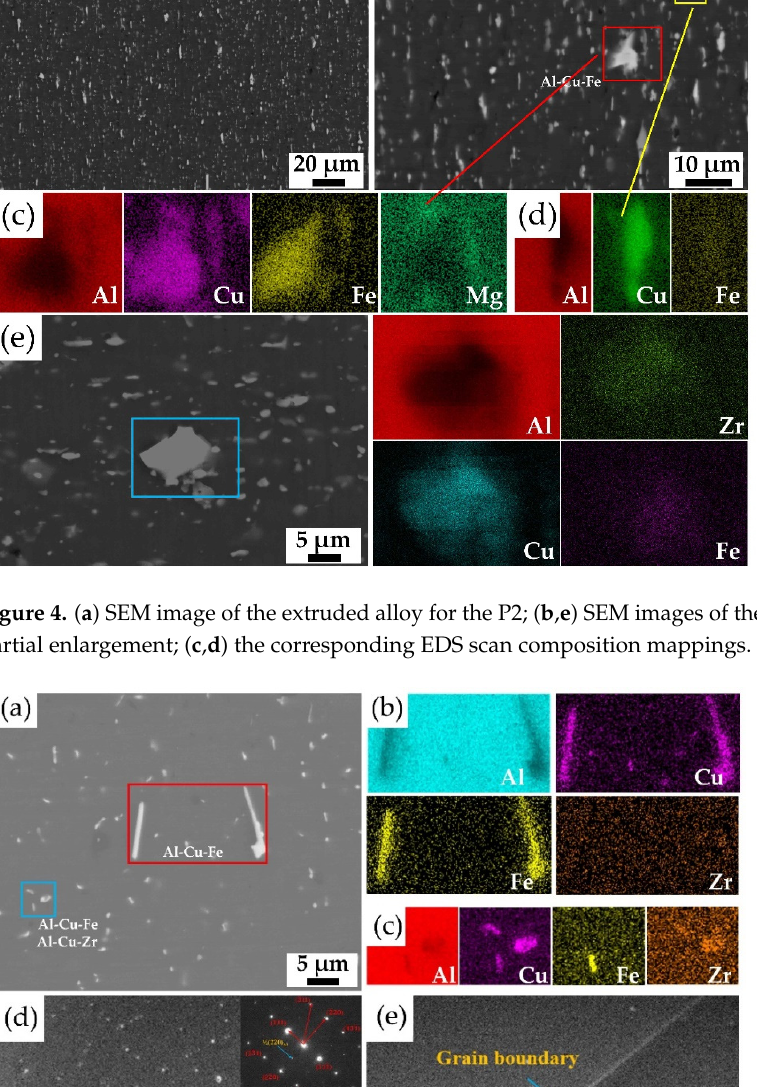
800 nm is formed close to the grain boundary.